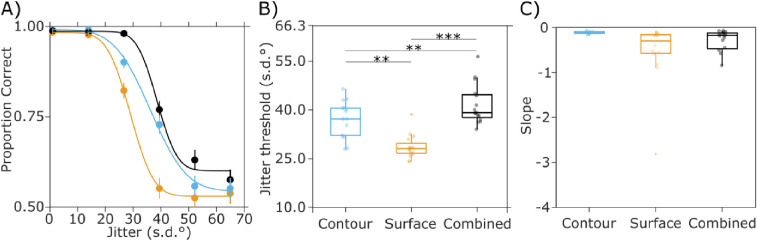
Results from the behavioral session. (A) shows the curves from probit regression for each experimental condition, data aggregated across participants. Error bars represent binomial 95% confidence interval (CI) for each estimated proportion of correct response. (B) Discrimination thresholds (inflection point of the curve) across participants, with significant differences between conditions indicated. (C) Slopes (gradients at inflection point) of the behavioral function per condition.